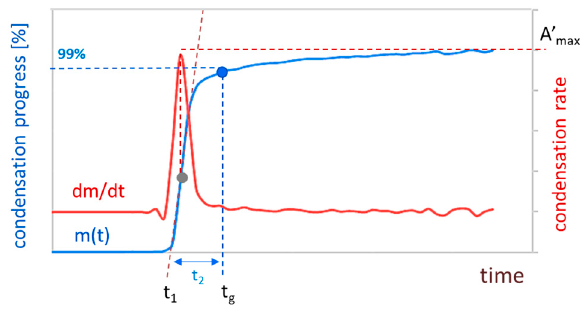
Figure 6. Scheme for quantitative analysis of condensation kinetics .